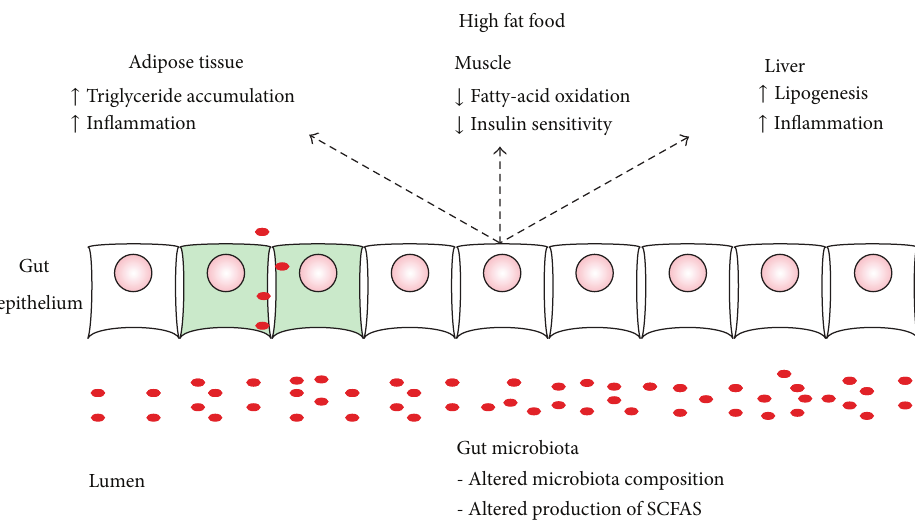
Figure 3: Effects of a high-fat diet. The altered microbial community of obese animals and humans promotes adiposity and decreased levels of short chain fatty acids and influences metabolic processes such as storage and metabolism of lipids in adipose tissue, muscle, and liver.